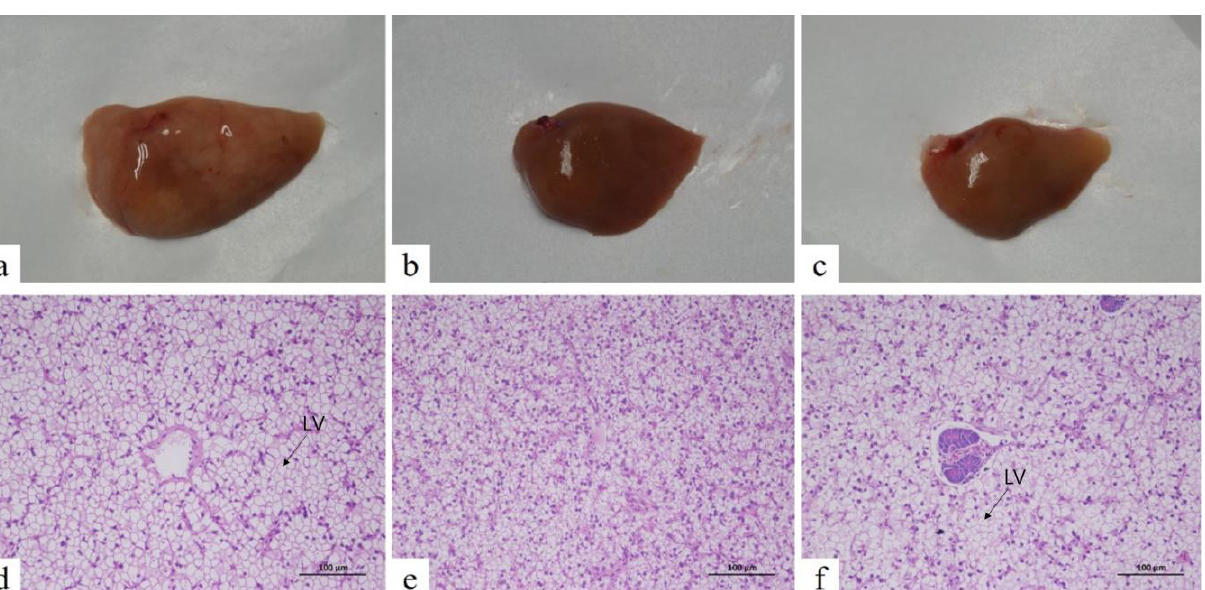
Figure 4. Effects of different levels of TM, instead of FM, on the expression of immune-related genes in the liver of Micropterus salmoides. Values with different letters represent significant differences in Tukey’s test ( p < 0.05). A = the variance analyzed by one-way ANOVA; L = linear trend analyzed by orthogonal polynomial contrasts; Q = quadratic trend analyzed by orthogonal polynomial contrasts.